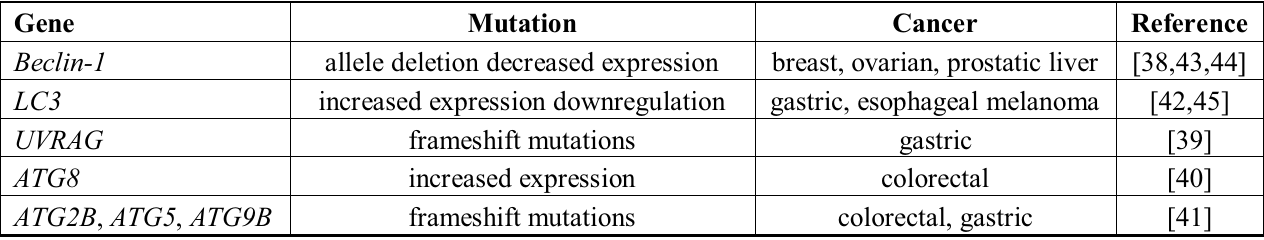
Table 1. Deregulation of some autophagic factors in human